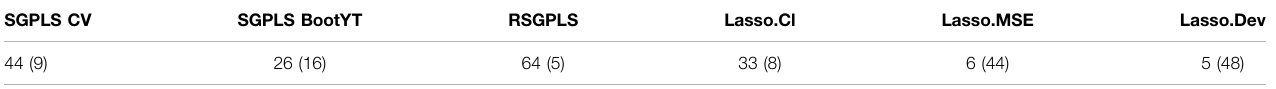
TABLE 7 | Number of different selected sets of tuning parameters over the 100 trials (rate of occurrence of the retained set of tuning parameters).